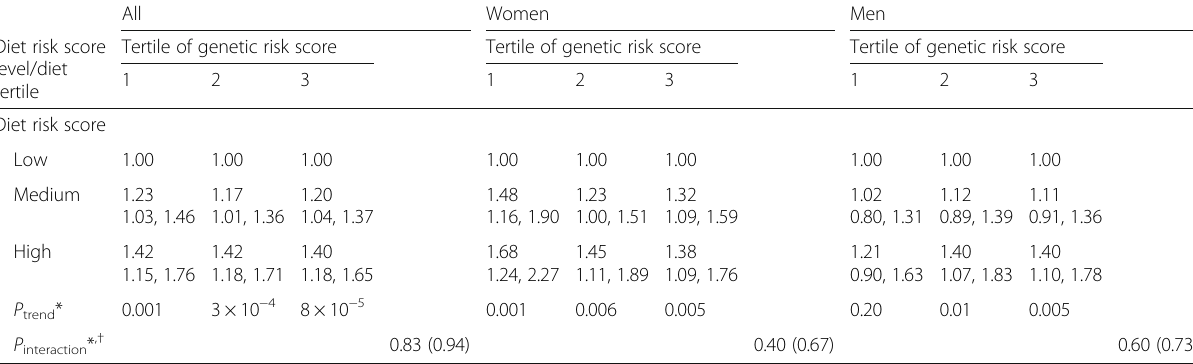
Table 4 Hazard ratios of incident type 2 diabetes according to a diet risk score based on intakes of processed meat, sugar- sweetened beverages (SSB), whole grain and coffee in strata of a weighted genetic risk score among 15,380 women and 9689 men from the Malmö Diet and Cancer Study